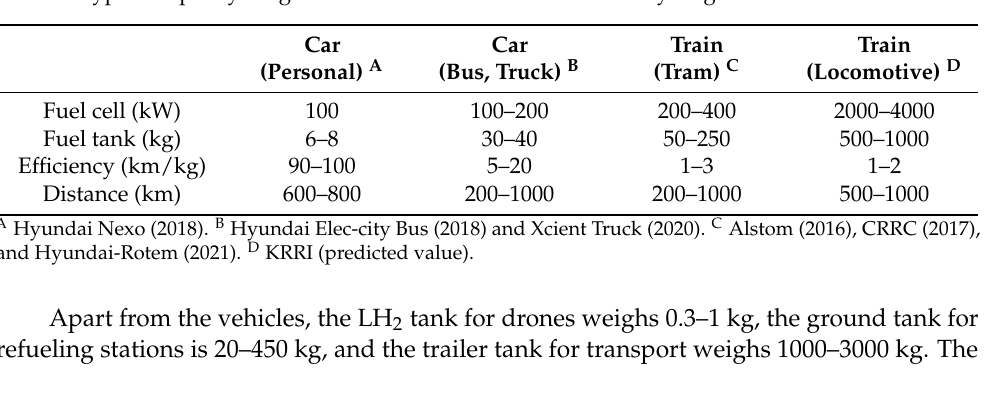
Table 4. Typical capacity ranges of the fuel cells and fuel tanks of hydrogen